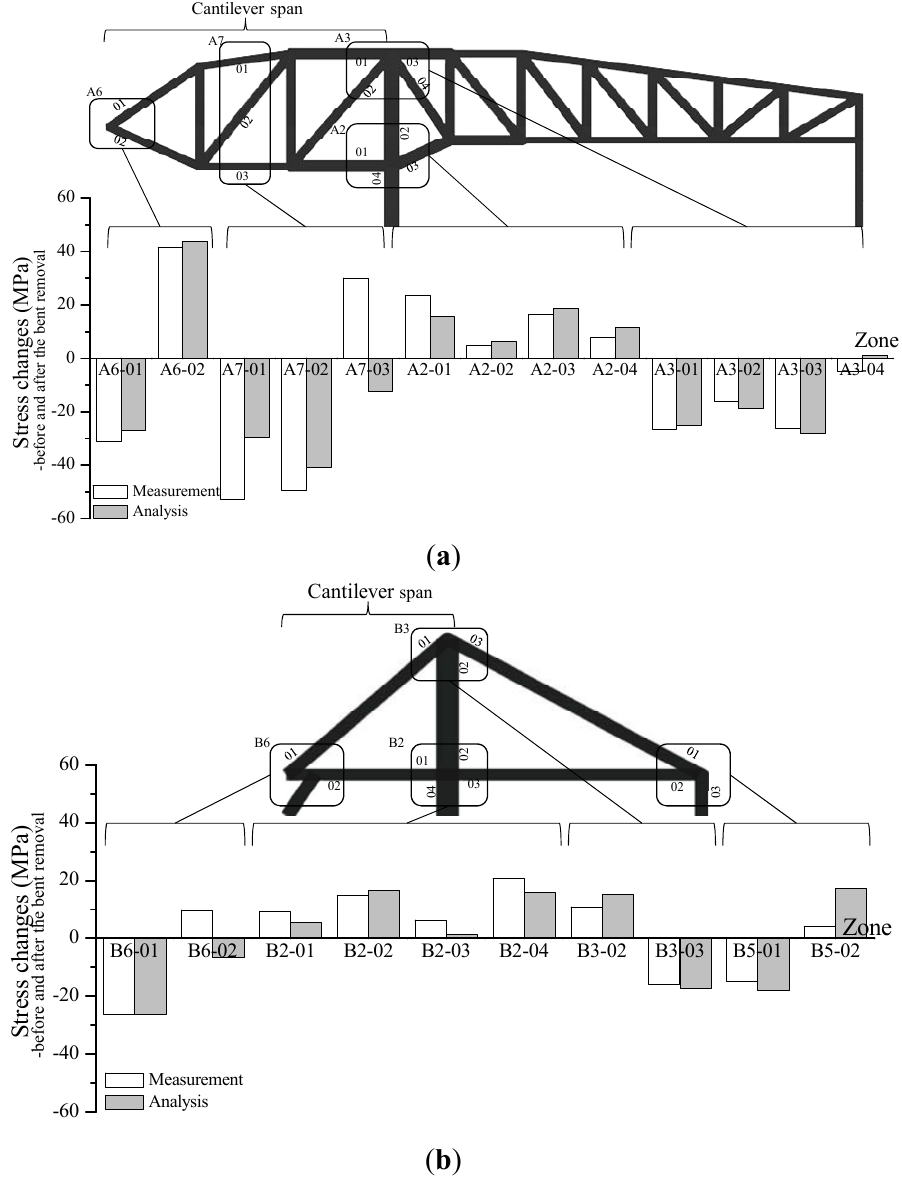
Figure 10. Stress changes before and after bent removal. ( a ) Zone A; ( b ) Zone